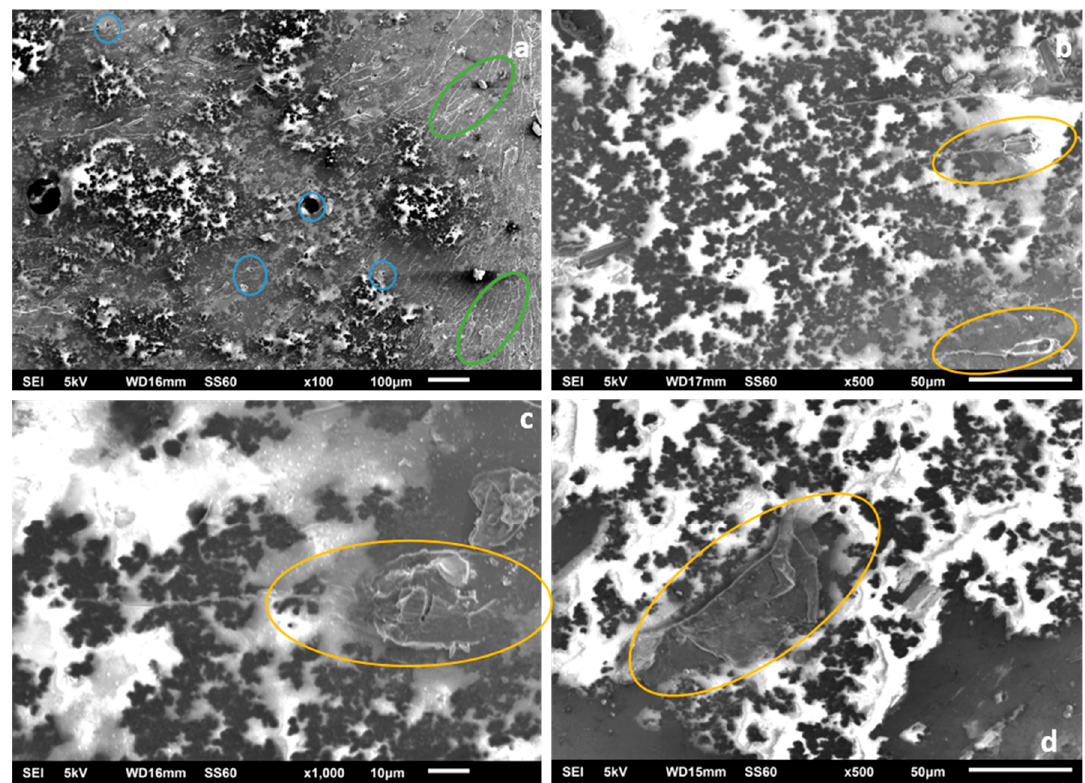
Figure 8. Scanning electron micrographs recorded from the fracture surface of a CNTs0.5_CB2-IV SENB specimen at ( a ) ×100, ( b ) and ( d ) ×500 magnifications, and ( c ) ×1000.